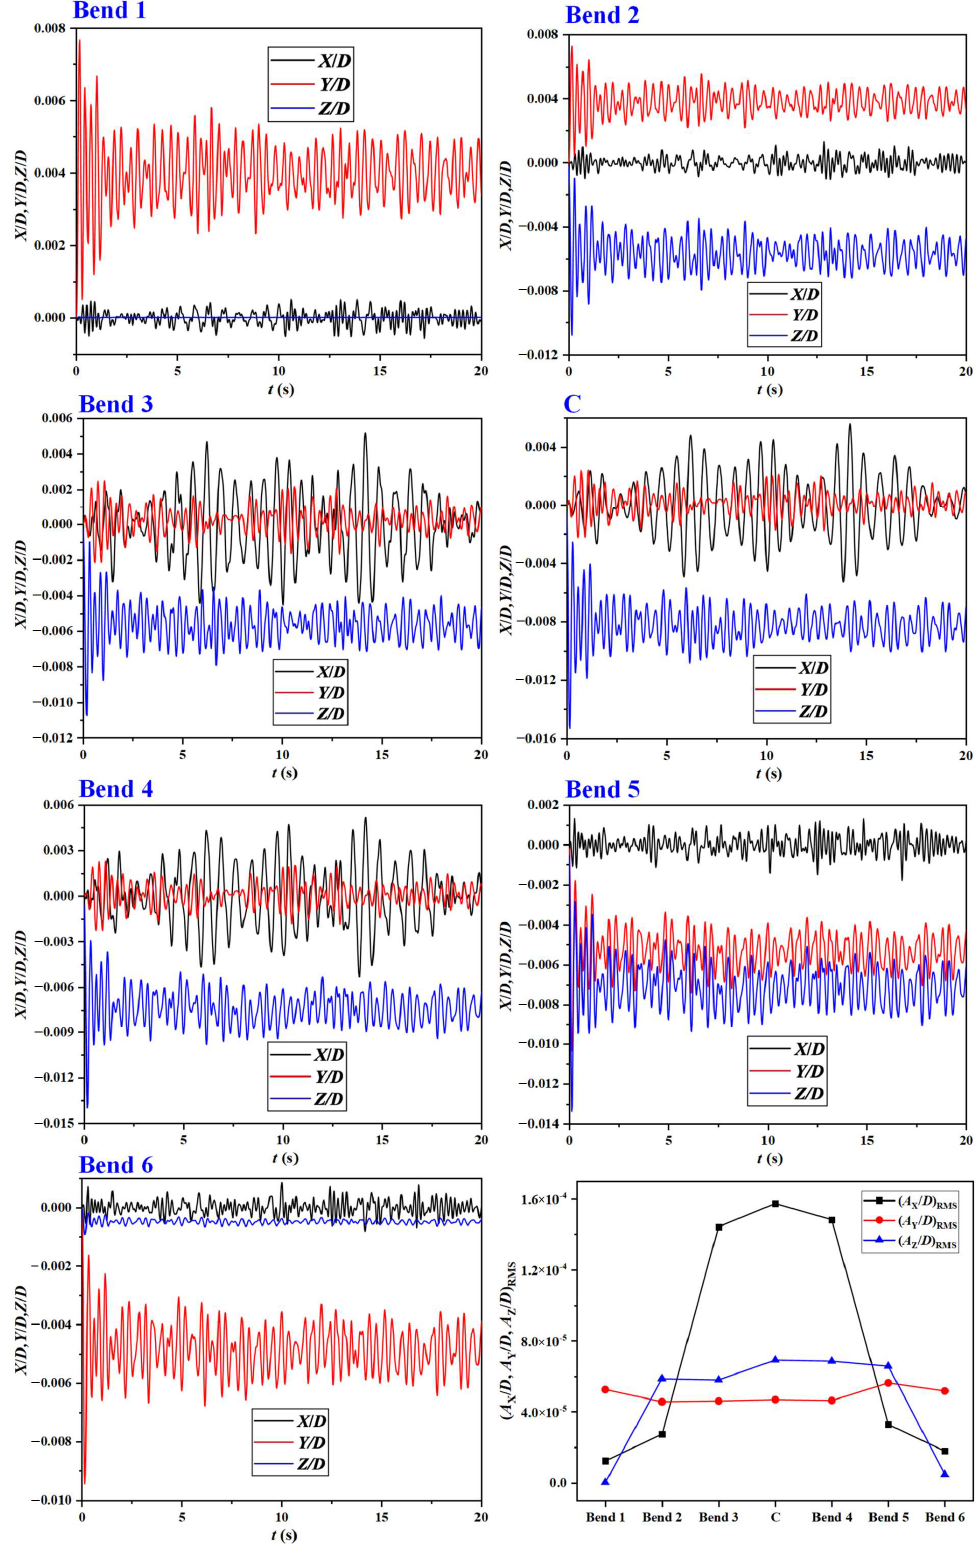
Figure 9. Time series of the normalized vibration displacements of the monitored bends and probe in case 1, where X / D , Y / D and Z / D are the normalized displacements in the three directions, and ( A X / D ) RMS , ( A Y / D ) RMS and ( A Z / D ) RMS are the root-mean-squared normalized amplitudes in the three